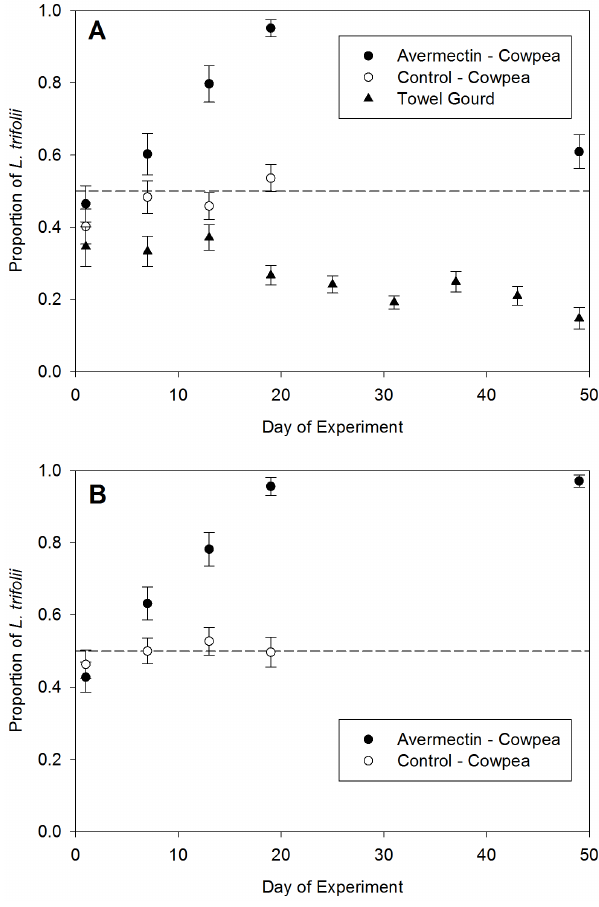
Figure 1. Liriomyza species composition during 2011. (A) mixed cropping systems of avermectin-treated and untreated cowpea ( Vigna uniguilata ), and adjoining plantings of towel gourd ( Luffa cylindrica ), and (B) plantings of cowpea that were treated with avermectin or were untreated controls. Avermectin treatments were made on days 1, 7, and 13 of the experiment following Liriomyza sample collections. Data points represent means 6 SEM.